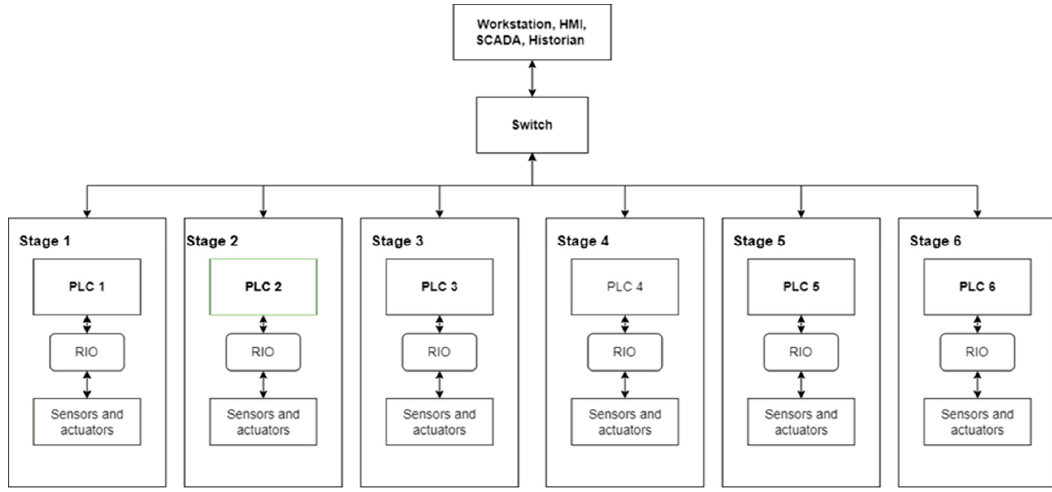
Figure 3. sWaT Network Architecture. Figure 3. SWaT Network